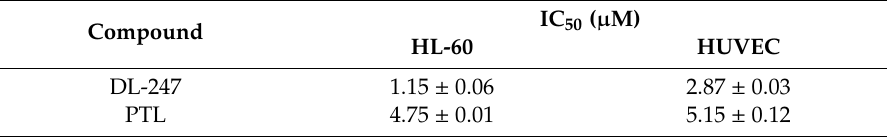
Table 1. Cytotoxic activity of DL-247 and PTL on HL-60 cell line and normal HUVEC cells.